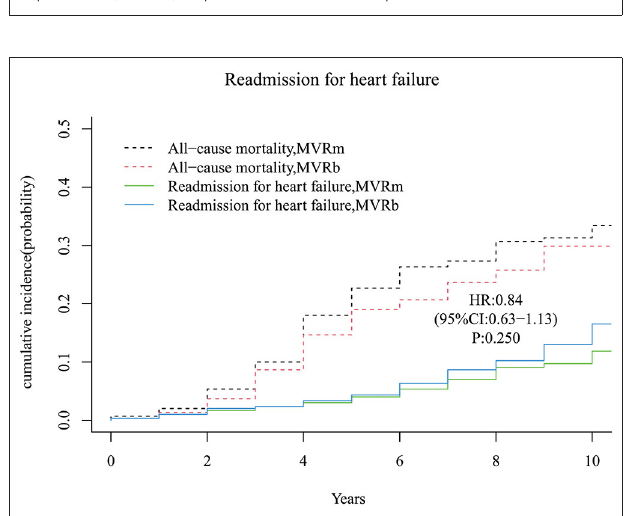
FIGURE 5 | Cumulative incidence of stroke. MVRm, mechanical mitral valve replacement; MVRb, bioprosthetic mitral valve replacement.